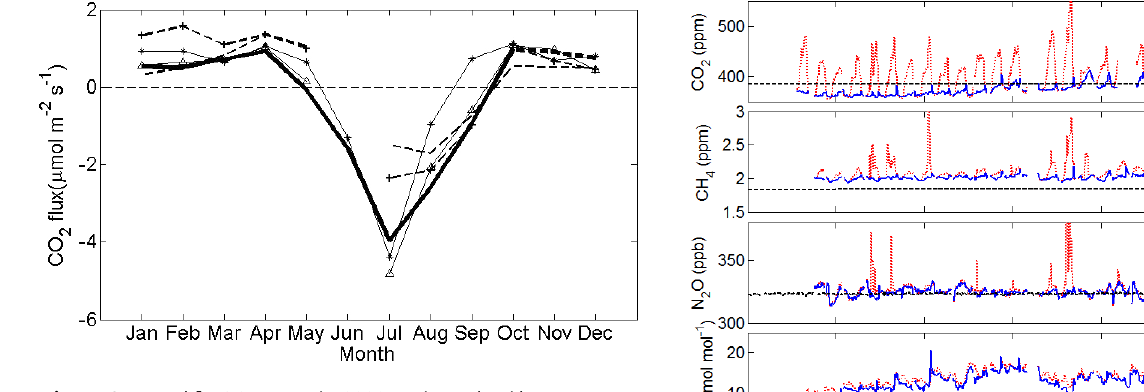
Figure 3. Monthly CO 2 flux in 2009 estimated with flux aggre- gation (FA, thick solid line), eddy covariance method ( F EC , line with triangles), CarbonTracker ( F CT , line with stars), equilibrium method with H 2 O as a tracer ( F EH , thin dashed line), and equilib- rium method using NCEP reanalysis data ( F EO , thin dashed line with cross). The FA flux ended in October because the grassland data was missing in November and December. The missing FA flux was determined by assuming the missing grassland flux in Novem- ber and December was the same as October flux (thick dashed line).